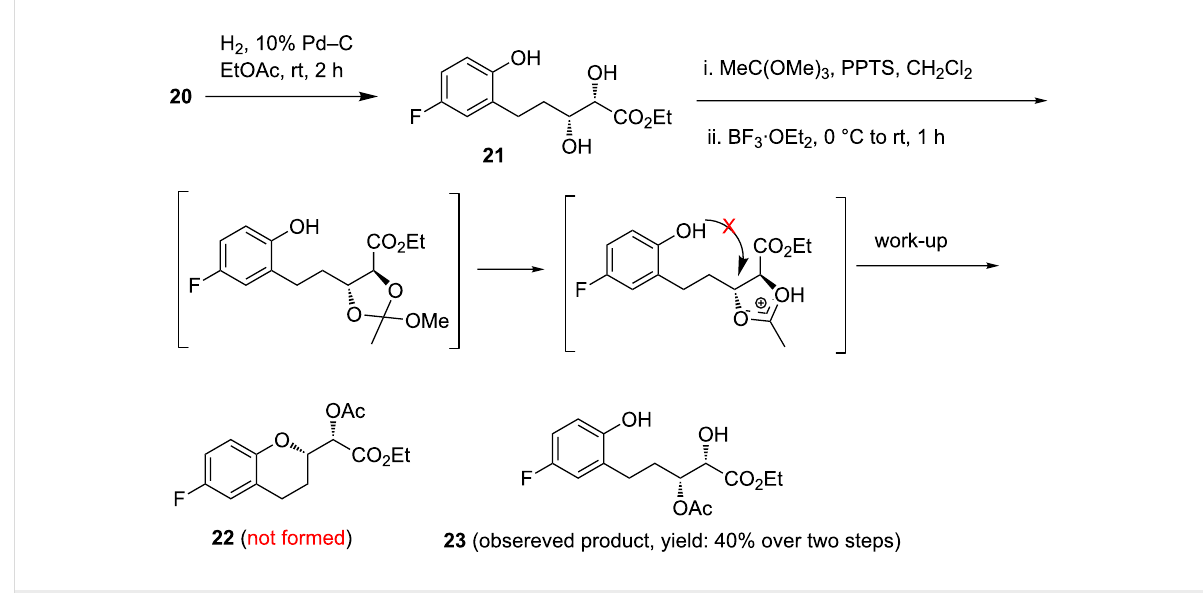
Scheme 5: Attempted cyclization according to Borhan’s